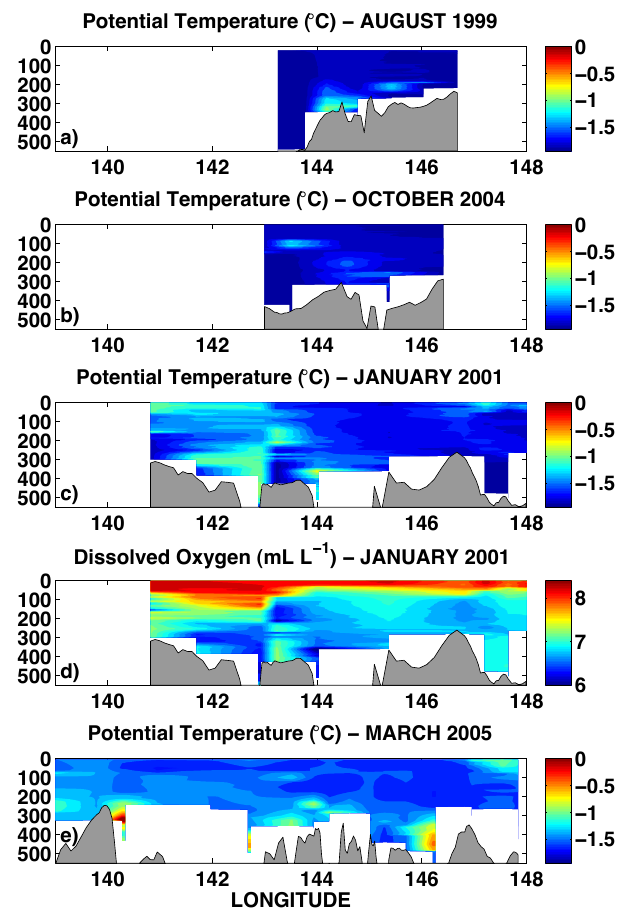
Fig. 6. Vertical sections of potential temperature ( ◦ C) across the AGV shelf break. Panels a–e (from top to bottom): winter (August 1999, A9901); spring (October 2004, NBP04–10); summer (Jan- uary 2001, NBP00-01); summer, dissolved oxygen (mLL − 1 ); and summer/fall (March 2005,